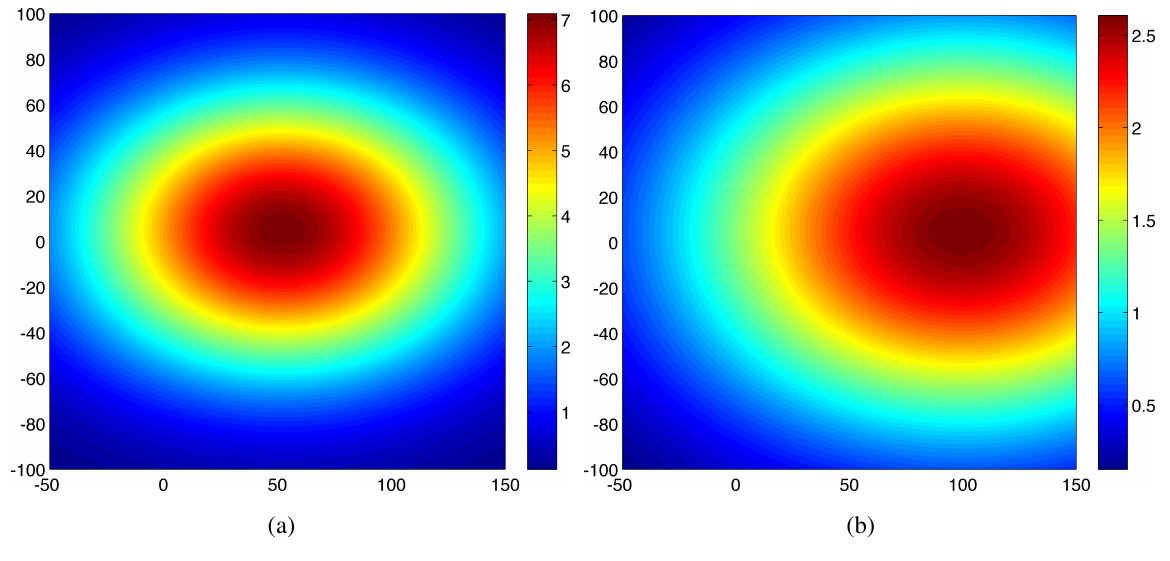
Figure 5. Snap shots of the advection-diffusion process at (a) t = 1 and (b) t = 20